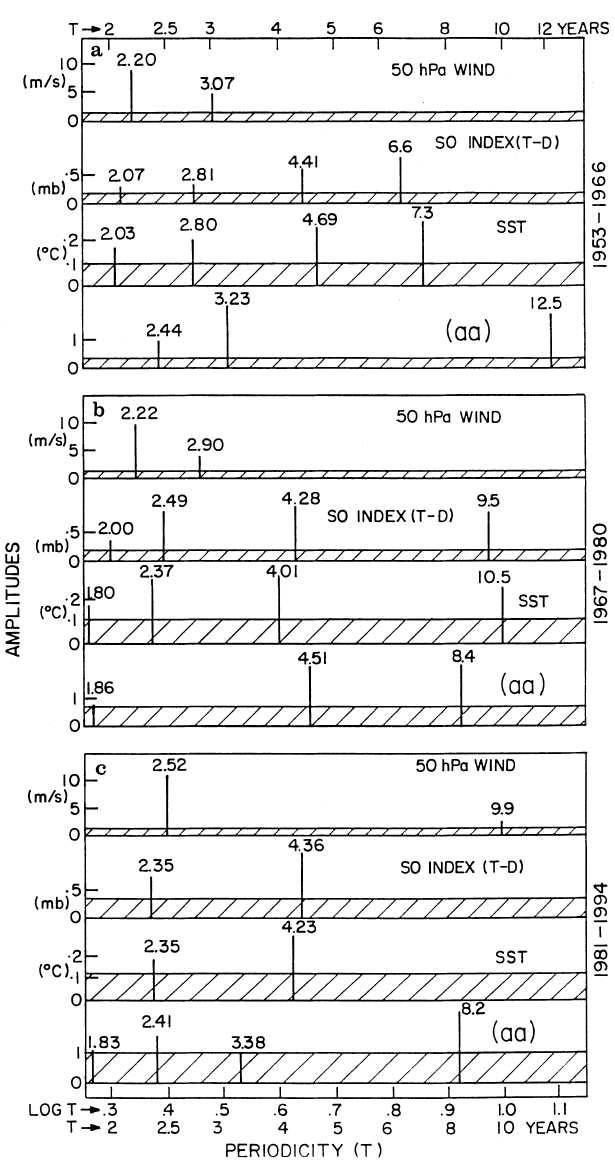
Fig. 13a–c. Spectra of the 12-monthly running mean series of 50 mb wind, SO index (T-D) , SST and aa (12-39) for three consecutive